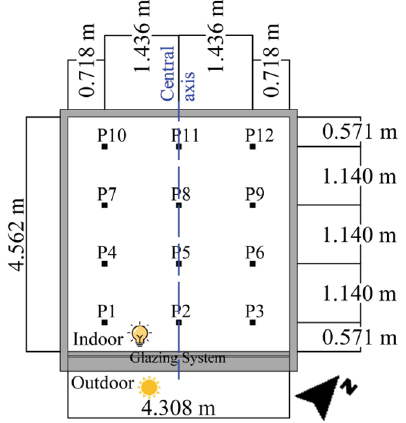
Figure 15. Location of the indoor daylight measuring points.